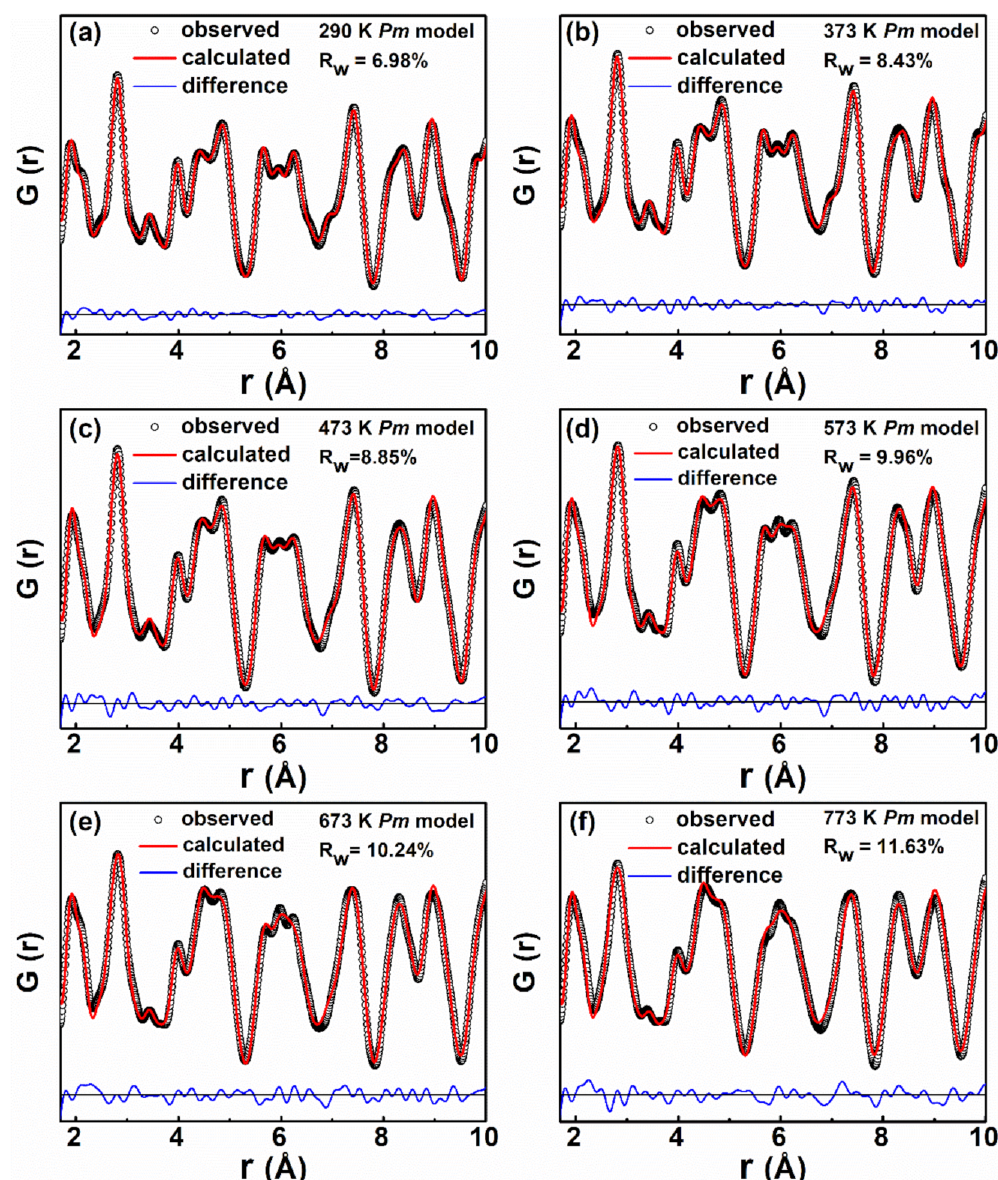
Figure 5. Experimental and fitted G( r ) profiles of KNNL6 for interatomic distance r < 10 Å, as a function of temperature: ( a ) 290, ( b ) 373, ( c ) 473, ( d ) 573, ( e ) 673, and ( f ) 773 K. The calculated profiles correspond to the fit obtained using a Pm space group, with starting parameters obtained from Rietveld analysis of the Bragg diffraction patterns at the corresponding